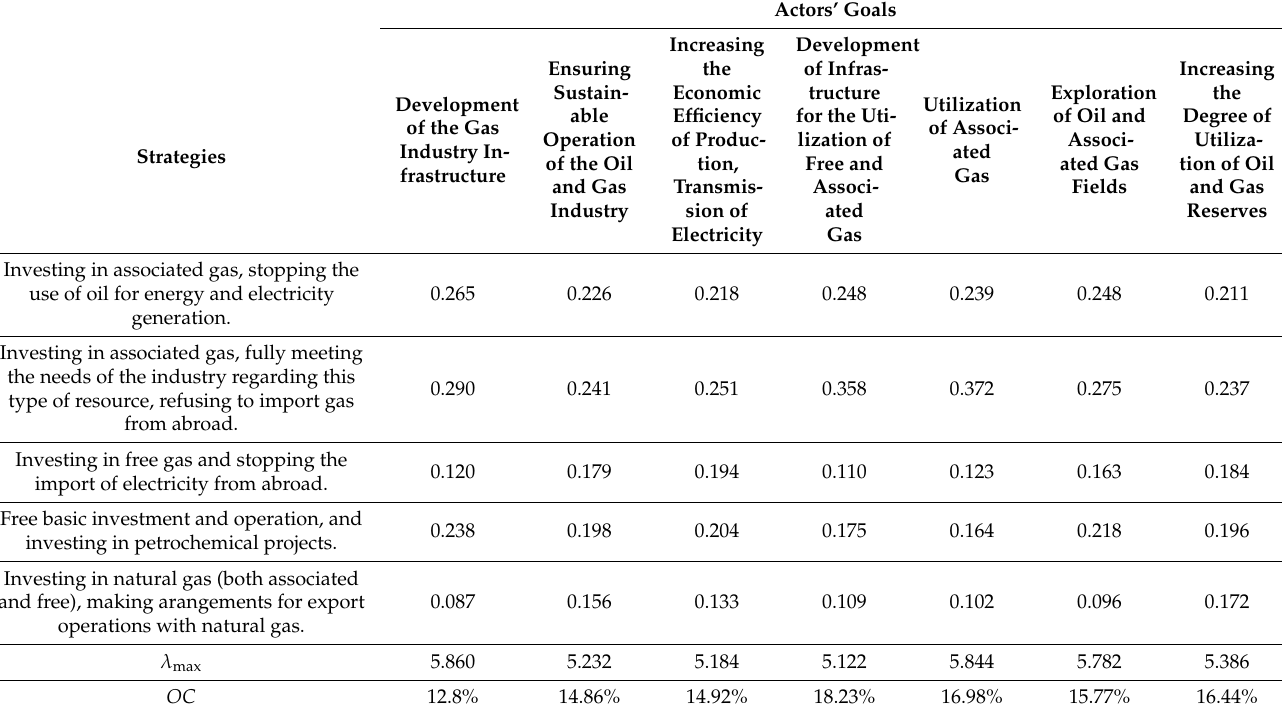
Table 6. Calculation results for the assessment of influence of the chosen strategy on the achievement of actors’